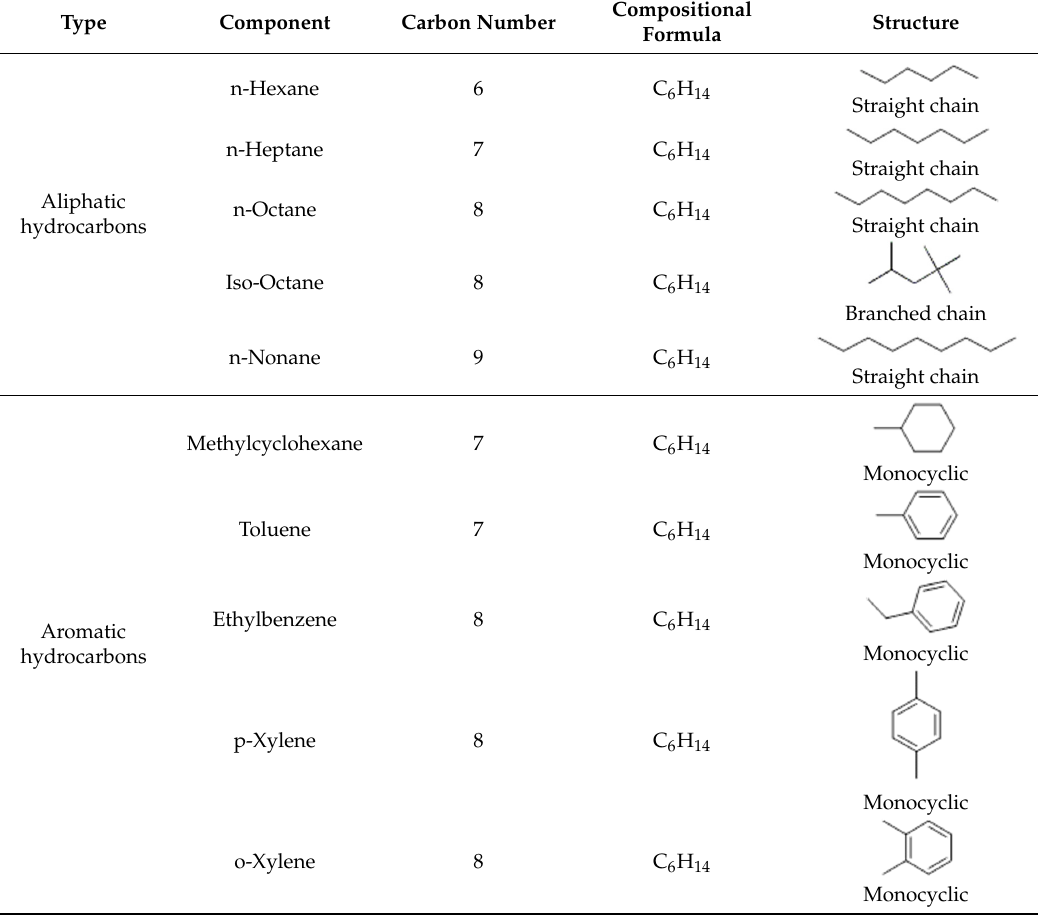
Table 1. Hydrocarbon components used to prepare a synthetic gasoline.